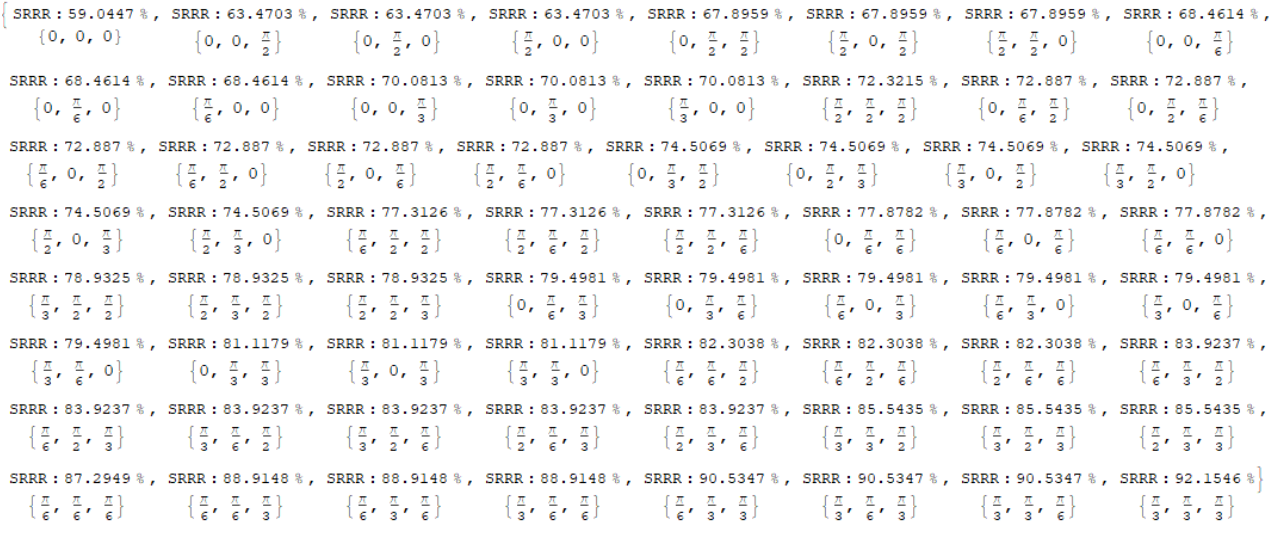
Figure 12. Solar Radiation Reception Rate for m = 3 and n = 3 at the equinox in the region of Makkah, Saudi Arabia .